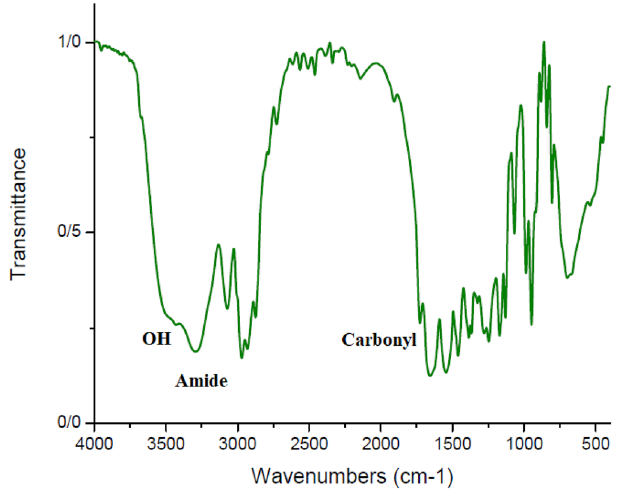
Figure 13. IR spectrum of cPNIPAAM produced in emulsion of SC-CO 2 in water.